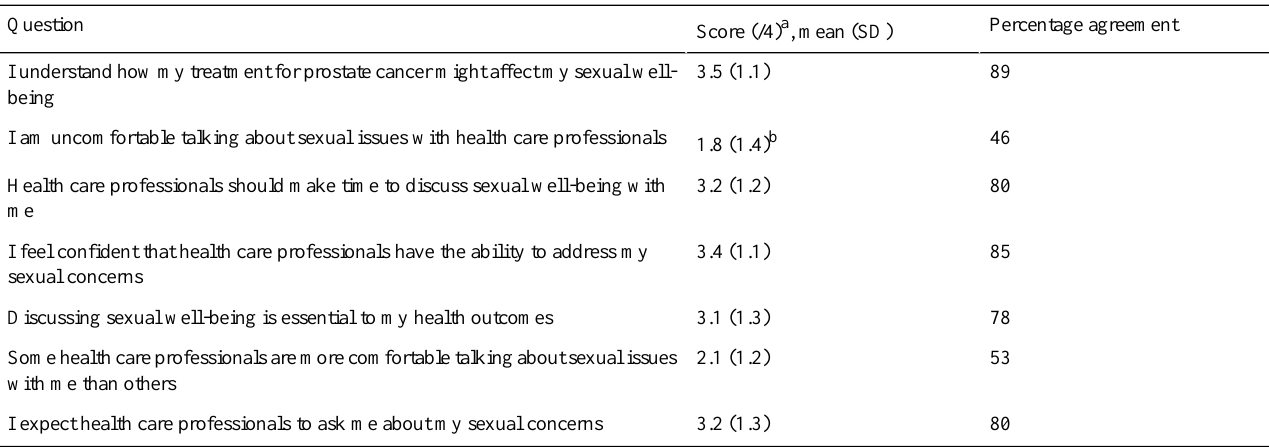
Table 2. Mean scores and percentage agreement for statements exploring patient sexual attitudes and